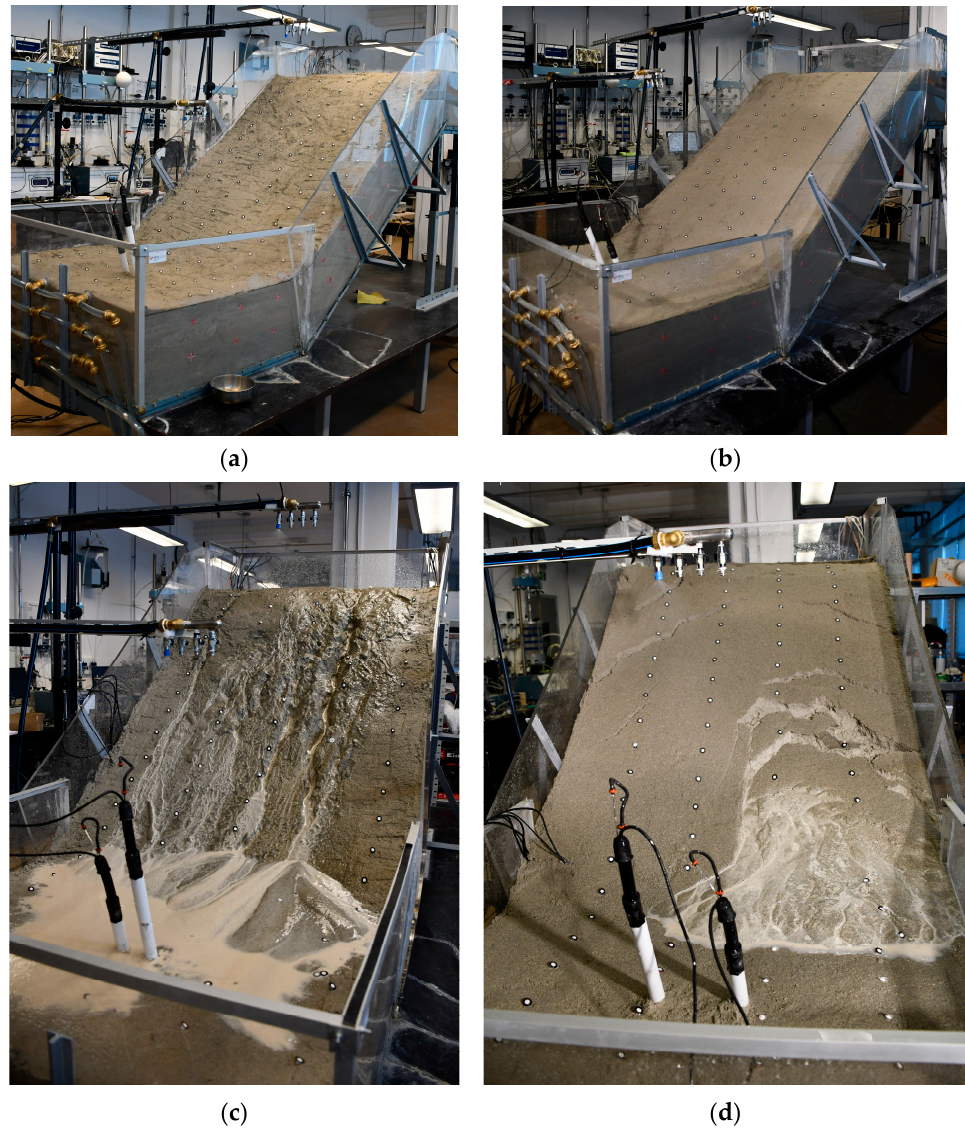
Figure 15. Two different types of instability depending on initial moisture in slope models: The slope model with higher initial moisture ( a ) leads to surface erosion ( c ), while the slope model with lower initial moisture ( b ) leads to the formation of cracks and landslides (d).